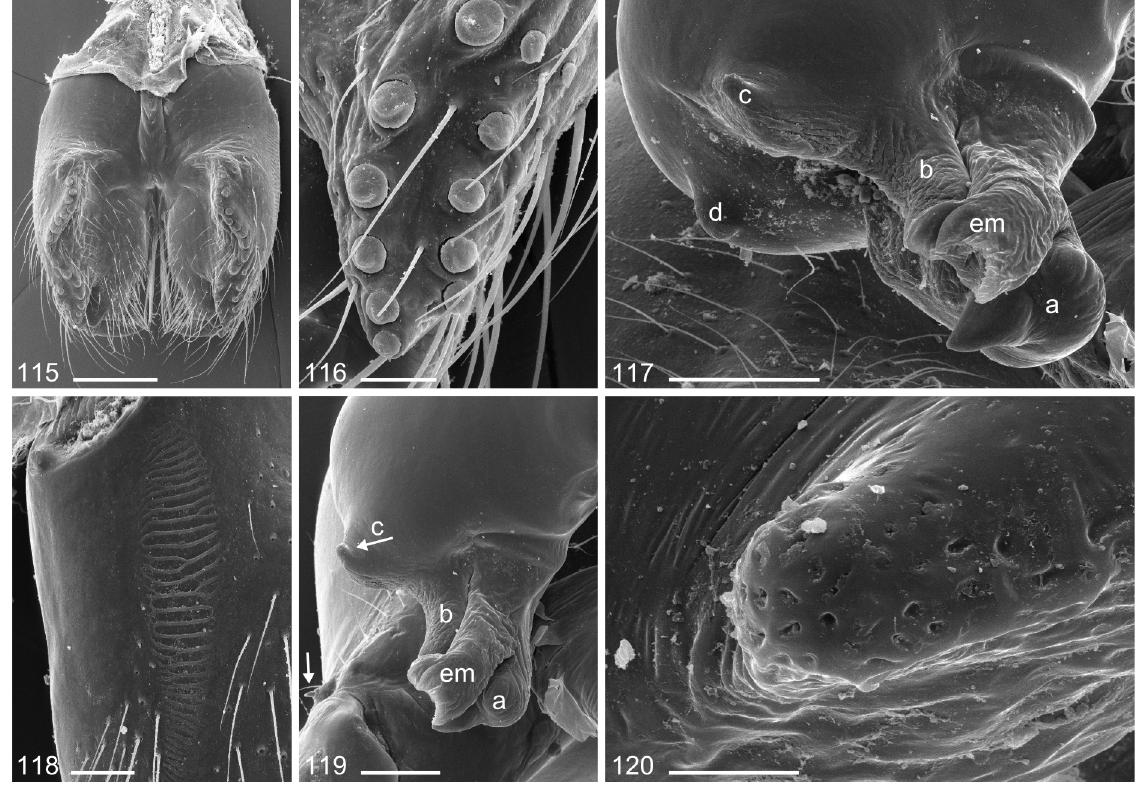
120 . Apophysis c with putative pores. Scale lines: 115 = 0.4 mm; 116 = 0.06 mm; 117, 119 = 0.2 mm; 118 = 0.1 mm; 120 = 0.02